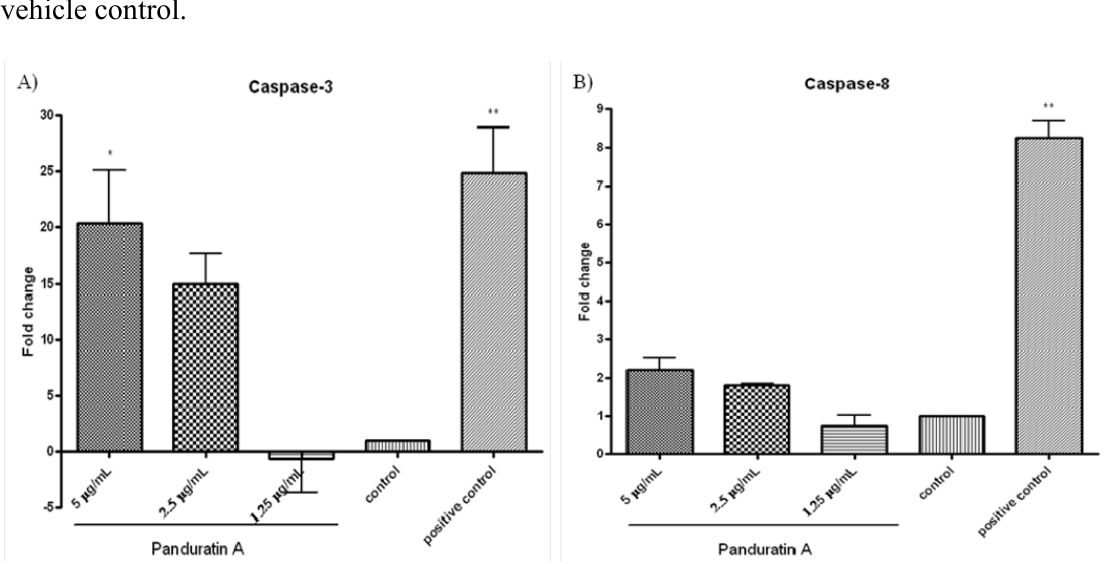
Figure 1. Effect of pandurartin A on caspases activation. Fold increase of the levels of ( A ) caspase-3 and ( B ) caspase-8 in A549 cells treated with various concentrations of PA, compared to vehicle control. The fluorescence intensity was measured at excitation wavelength of 390 nm and emission wavelength of 500 nm. The increase of protease activities was determined by comparing the levels in PA-treated A549 cells with the vehicle